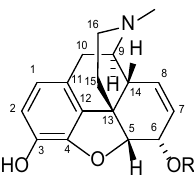
Figure 6. R = H: Morphine; R = CH 3 : Codeine. Adapted from Ref. 21.